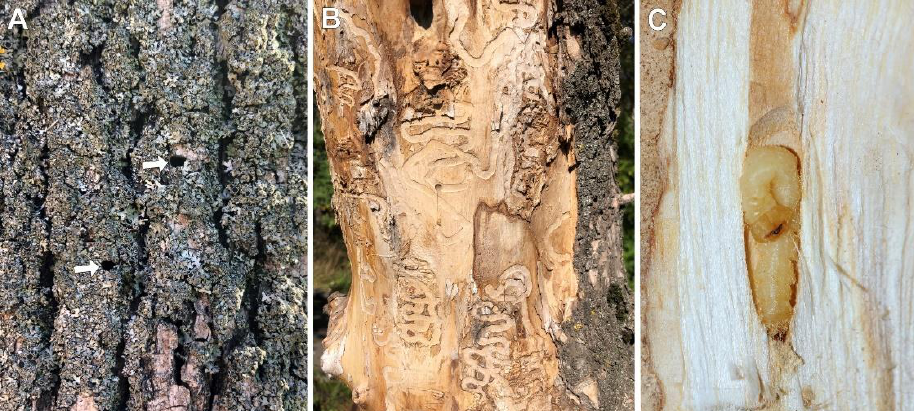
Figure 2. The emerald ash borer, Agrilus planipennis on ash trees: ( A ) Exit holes, shown by white arrows; ( B ) Old galleries on a dry-sided stem; ( C ) Larva.